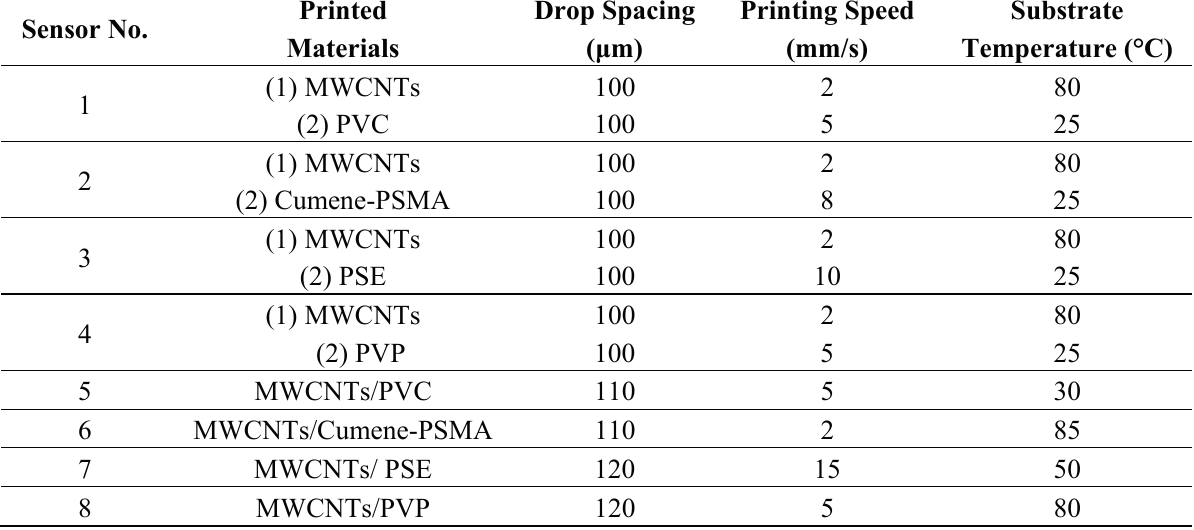
Table 1. Dispensing parameters of the Autodrop micro dispensing system to deposit the sensing layers.